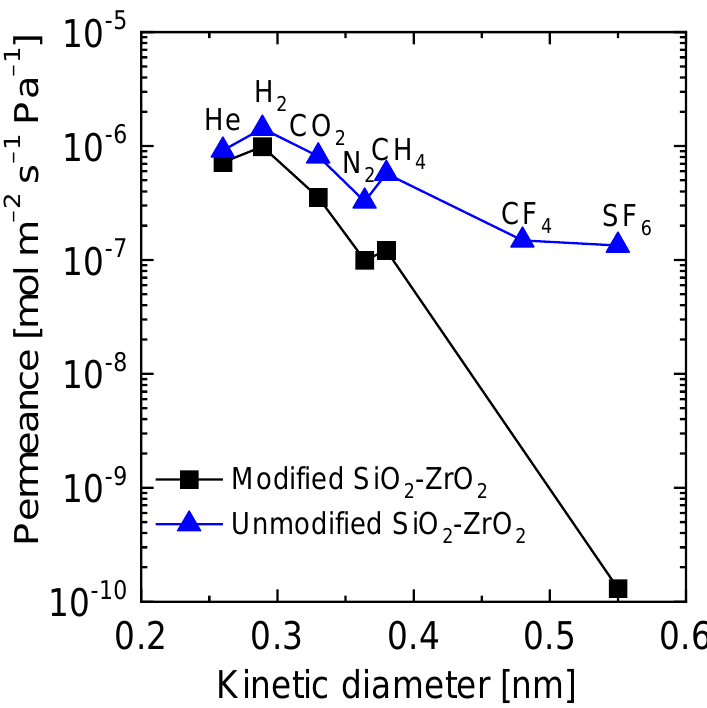
Figure 12. Molecular size dependence of single-gas permeance at 200 °C for SiO 2 -ZrO 2 -AcAc and pure SiO 2 -ZrO 2 membranes. Adapted from [87].